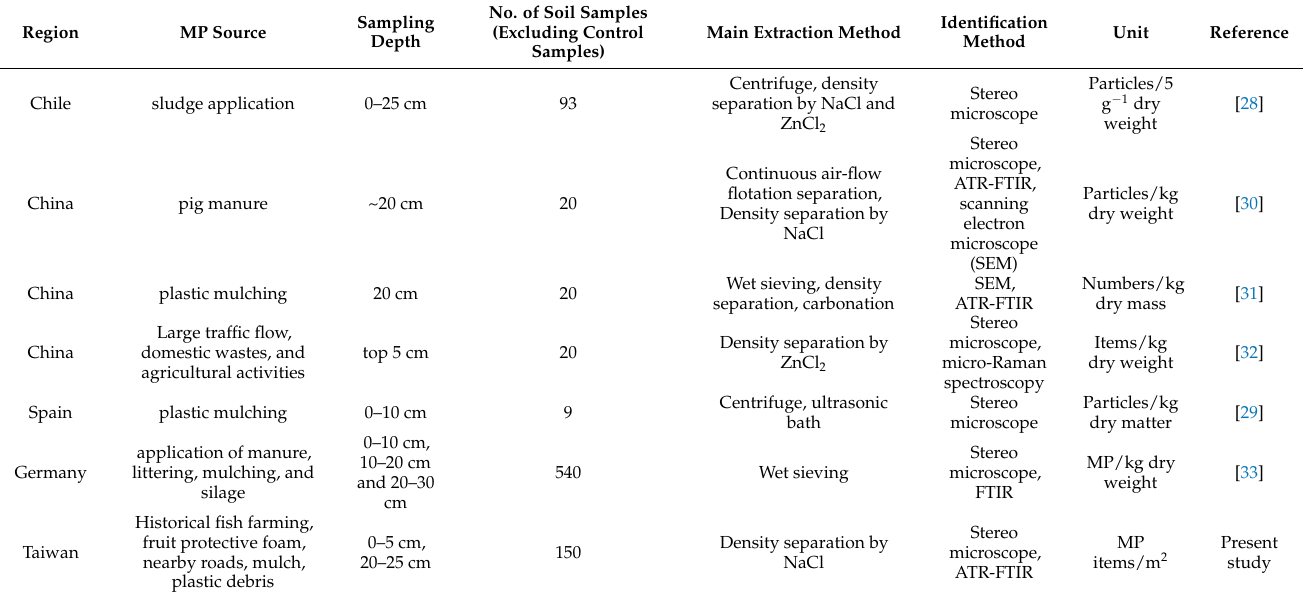
Table 1. Recent studies on MP identification in agricultural